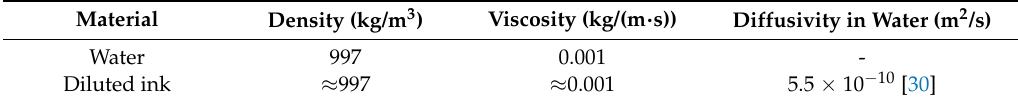
Table 2. Physical properties of water and diluted ink.